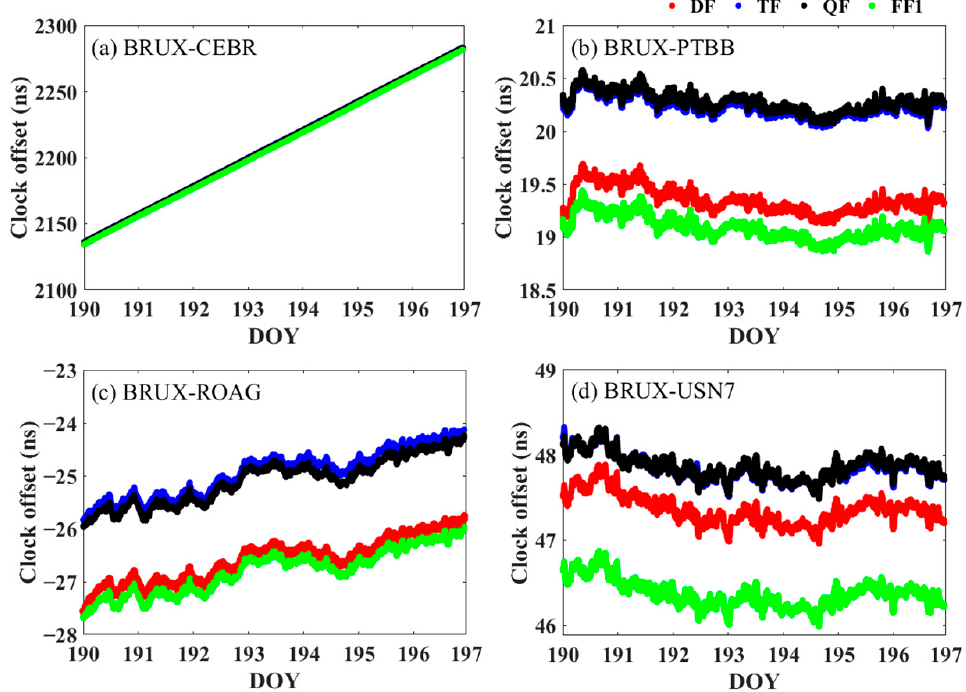
Figure 6. Clock offset sequence at four time-frequency links for the DF, TF, QF and FF1 PPP models on DOYs 190 to 196 in 2020. ( a ) BRUX-CEBR time-frequency link; ( b ) BRUX-PTBB time-frequency link; ( c ) BRUX-ROAG time-frequency link; and ( d ) BRUX-USN7 time-frequency link.